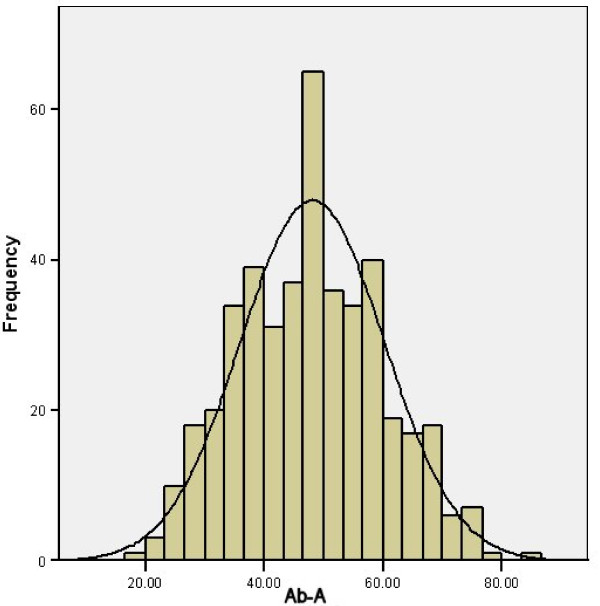
Histogram of Ab-A.